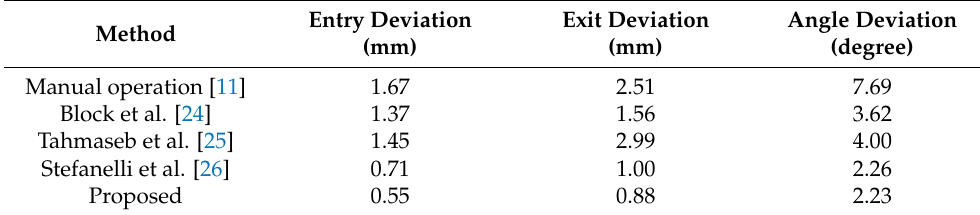
Table 2. Comparison of results obtained from different implant methods. “Proposed” represents the system proposed in this